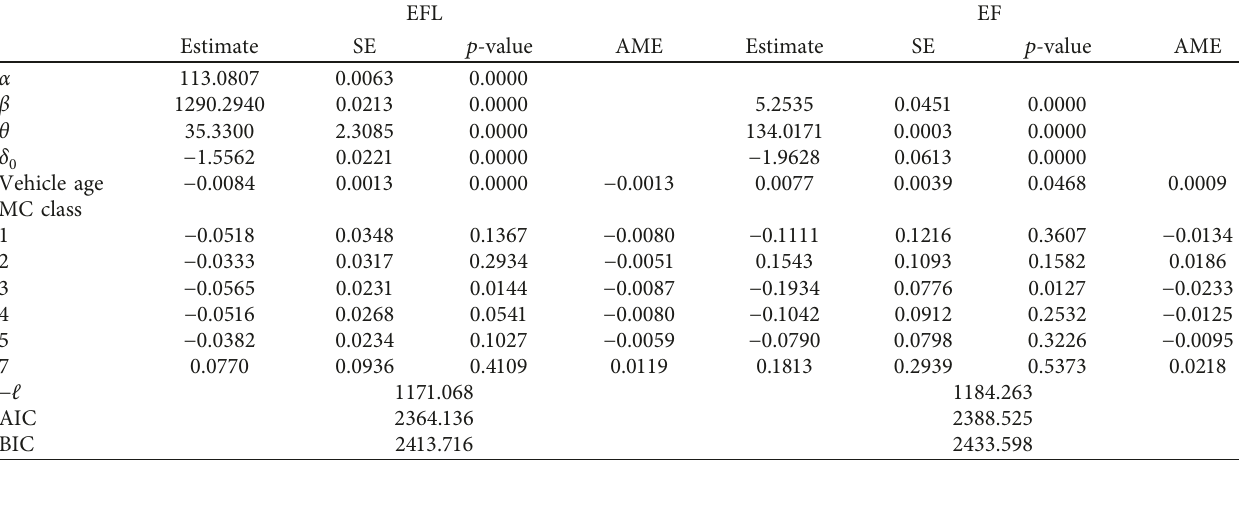
Table 12: Regression parameter estimates.